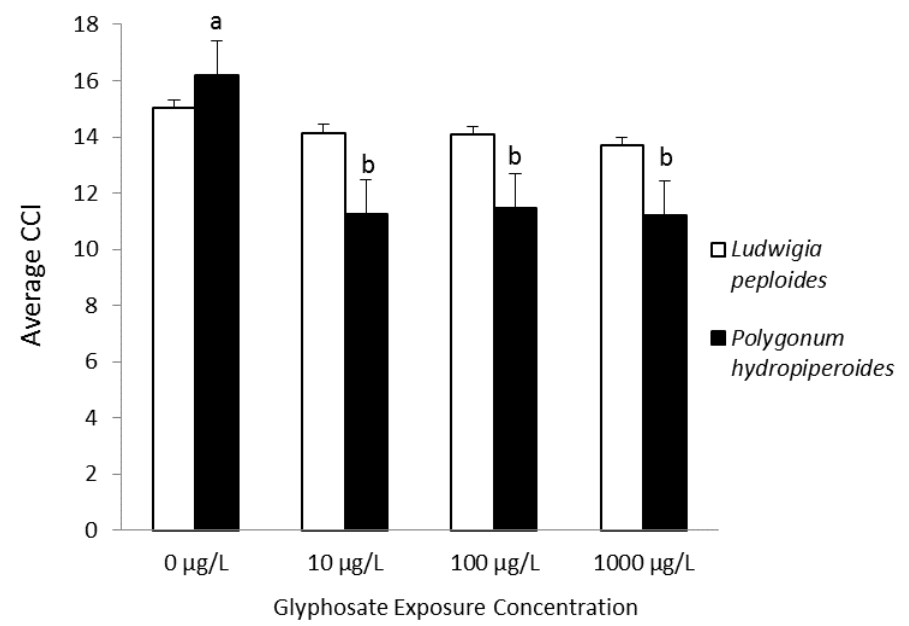
Figure 3. Average chlorophyll content index (CCI) measurements for Days 1–17. Bars represent the means ± the standard error. Lowercase letters (a,b) refer to significant differences across treatments within species. Differences considered significant at α < 0.05 [94], Copyright 2014,